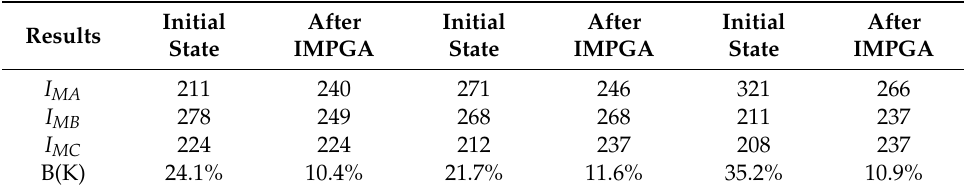
Table 4. The results comparison.